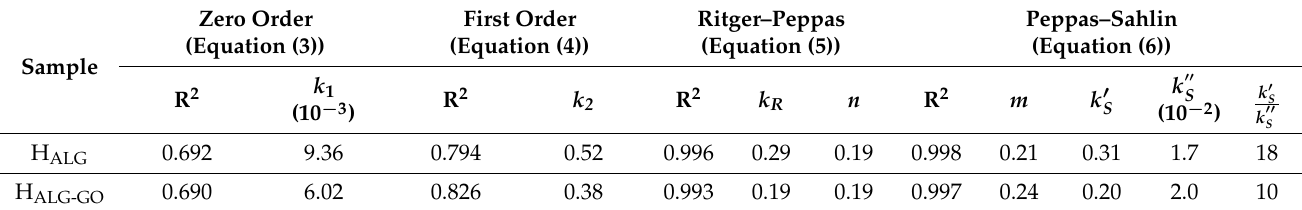
Table 1. Kinetic parameters of CUR release from hybrid and blank ALG